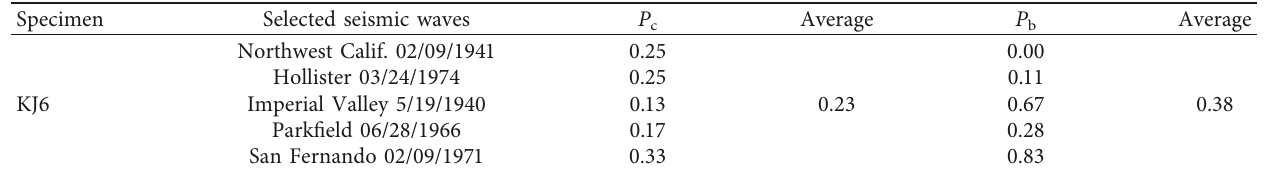
Table 11: Plastic hinge rates of beams and columns in model KJ6.